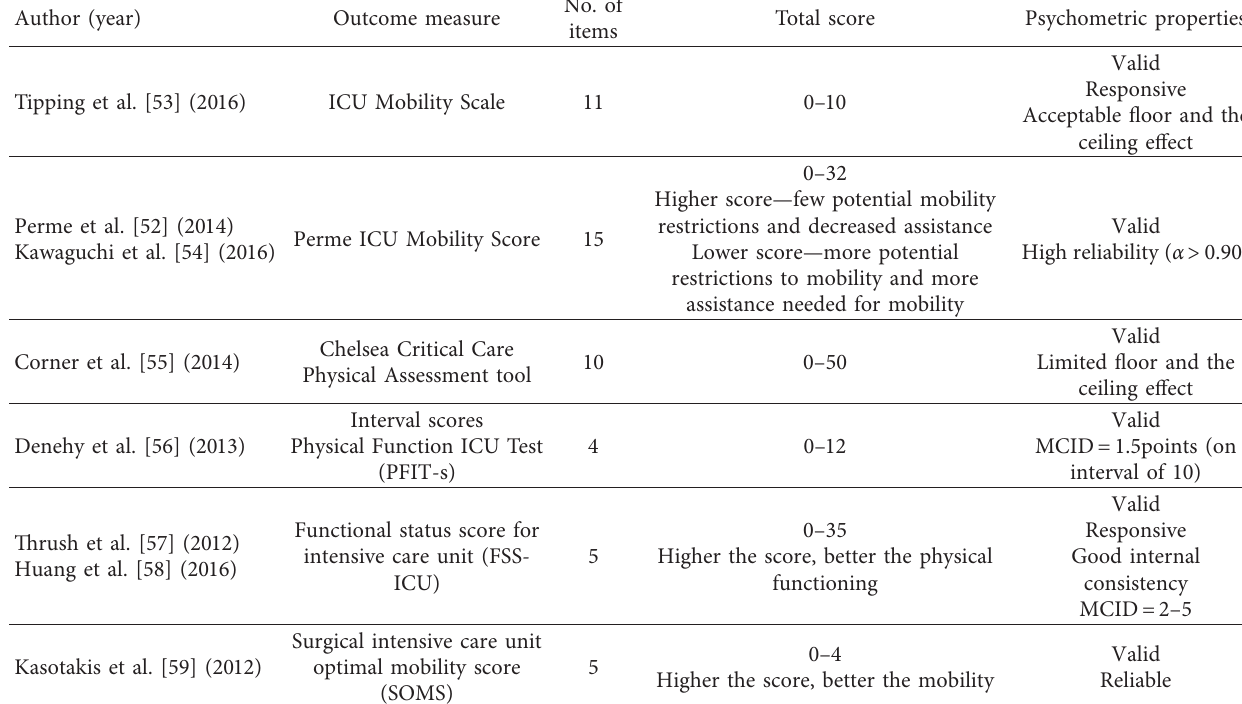
Table 4: Outcome measures for assessing the effectiveness of early mobilization on mobility in the intensive care unit.